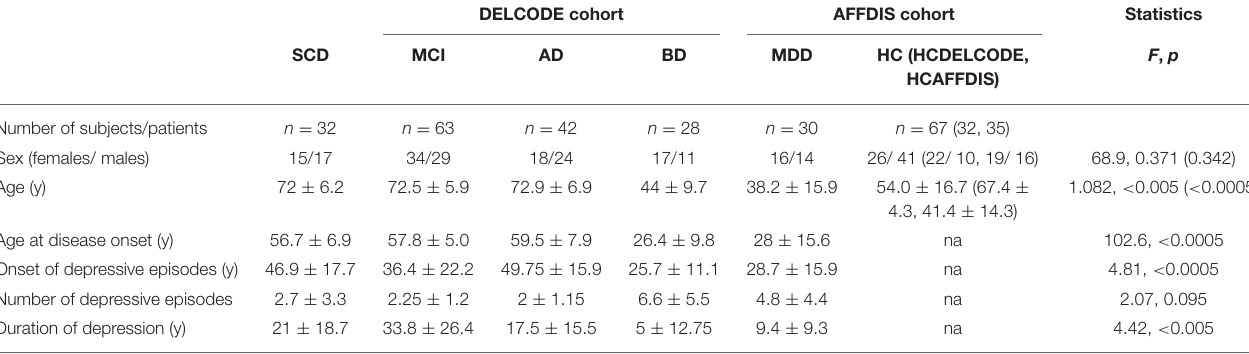
TABLE 1 | Demographic and clinical information of patient and control